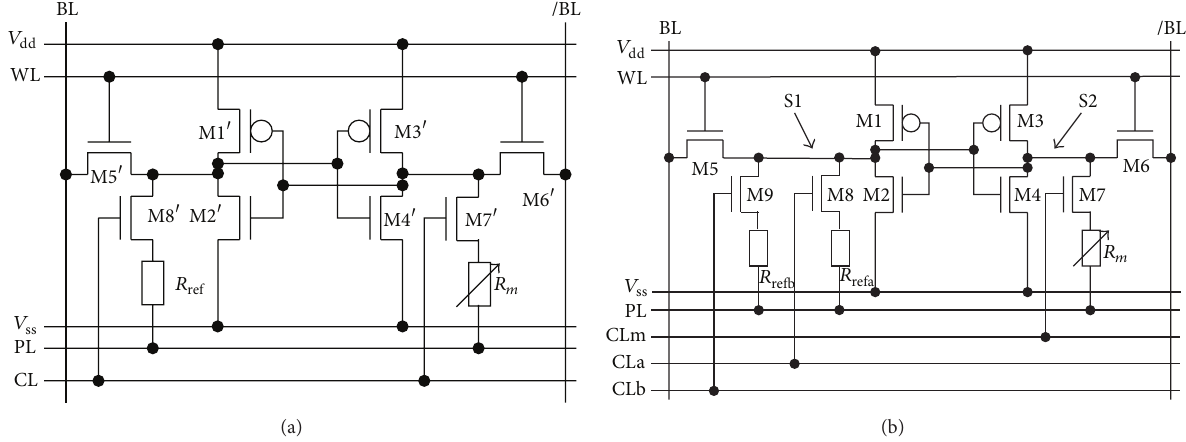
Figure 3: (a) Conventional NV-SRAM cell and (b) proposed MNV-SRAM.